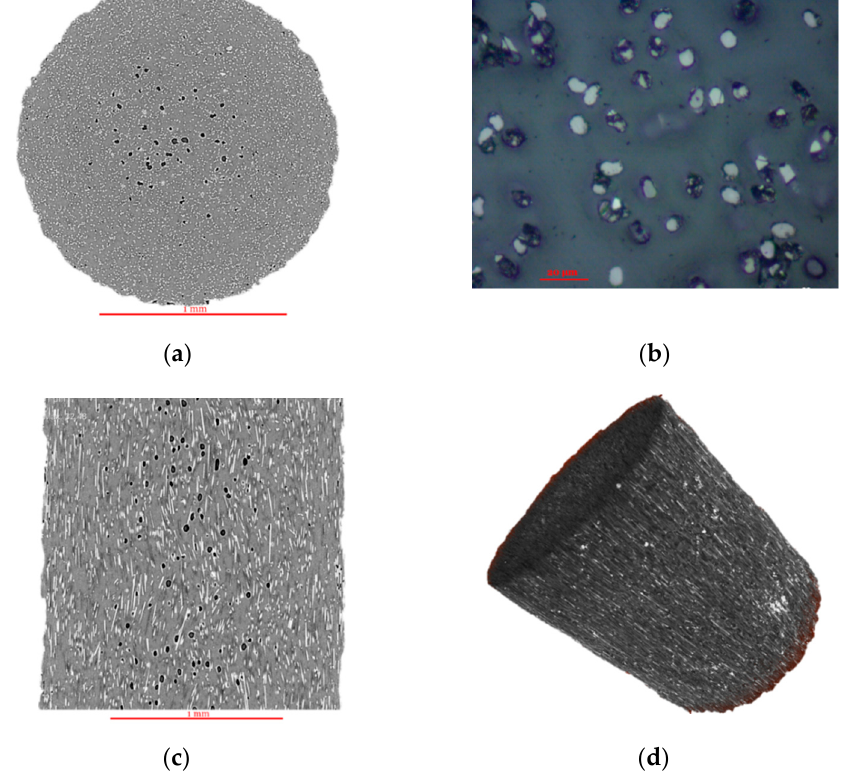
Figure 3. Different views of Onyx plastic filament: cross-sectional view from nano-CT scanning